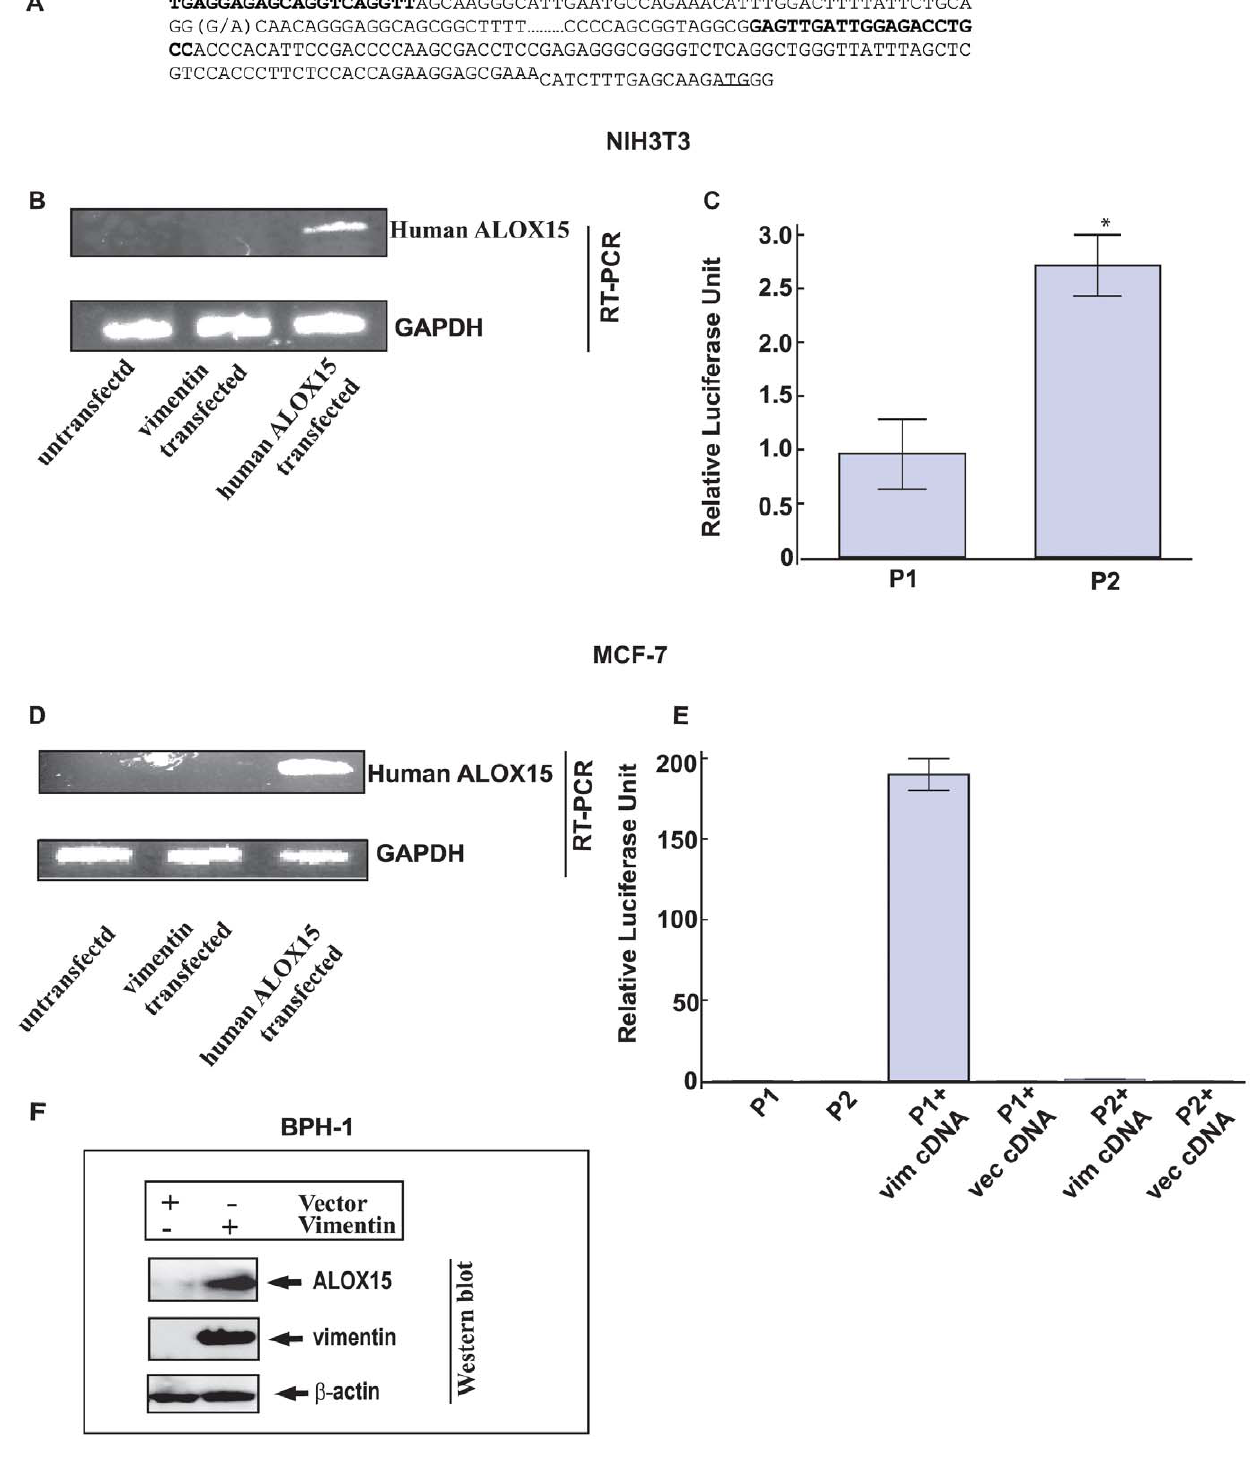
Figure 2. Promoter activities of ALOX15 variants in NIH3T3 cells and MCF-7 cells. Vimentin binds to ALOX15 promoter ( A ) ALOX15 promoter sequence. Primers used for this study and alternative alleles of rs2255888 are shown in bold. (G/A) in bold denotes SNP rs2255888 position. ( B ) Qualitative measurement of human ALOX15 (upper panel) and GAPDH (lower panel) gene expression by RT-PCR in NIH3T3 cells. ( C ) Luciferase activities of P1 and P2 transfected NIH3T3 cells was measured after 24 h. *denotes p=2 6 10 2 5 vs. P2. The results are the average of two independent transfections performed in triplicate 6 S.E. ( D ) Human ALOX15 (upper panel) and GAPDH (lower panel) gene expression by RT-PCR in MCF-7 cells in presence of vimentin. ( E ) Luciferase activities of P1 and P2 transfected MCF-7 cells were measured after 24 h. The experiments were done in triplicates. **denotes p , 0.0001 between the experimental sets. Transfection of NIH3T3 cells and MCF-7 cells with human ALOX15 cDNA for 24 hr was performed separately as control in gene expression experiments. pRL and pTK luciferase constructs were co-transfected in NIH3T3 and MCF-7 respectively. Luciferase activity was normalized using pRL and pTK luciferase activity in NIH3T3 and MCF-7 respectively. The results are the average of